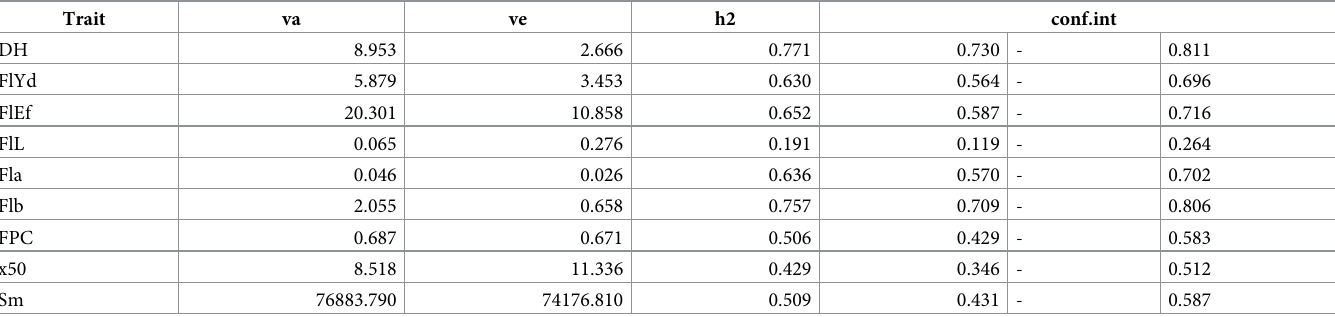
Table 2. Marker-based estimate of heritability for each trait.